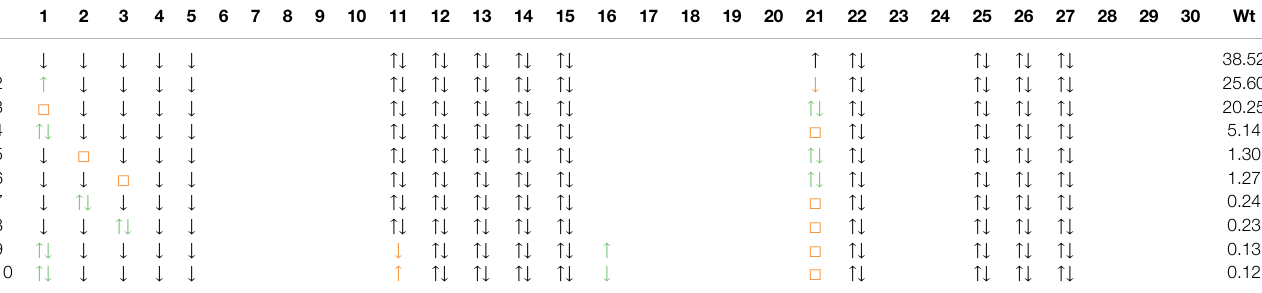
TABLE 5 | Dominant ten SD con fi gurations and their weights (in %) in the d 8 wavefunction for CaCuO 2 . See the caption of Table 4 for details of the wavefunction